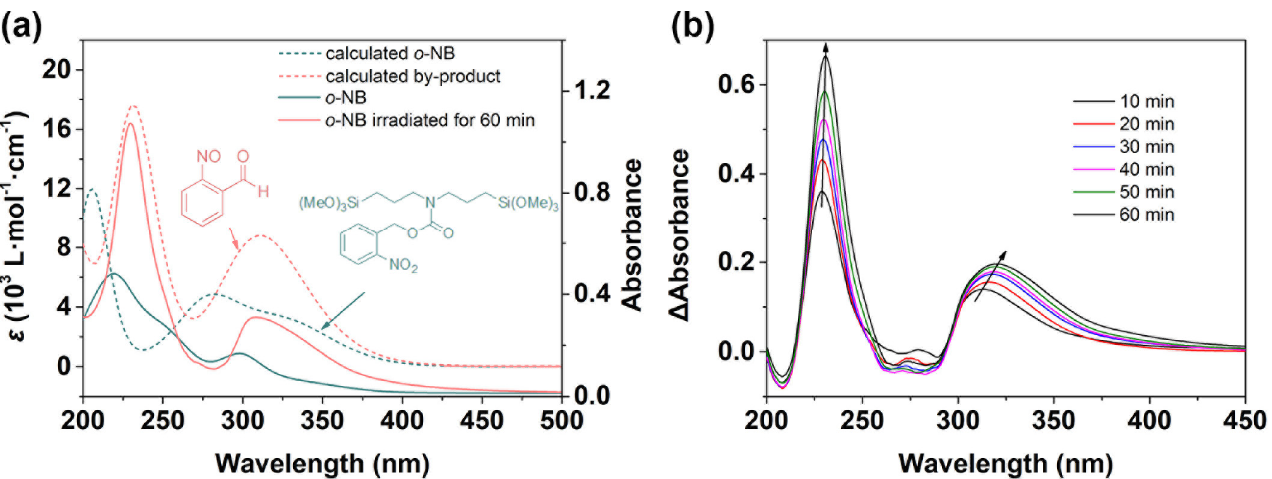
Figure 2. ( a ) The measured (solid line) and theory calculated (dotted line) UV–vis spectra of o –NB in THF solution under light irradiation at 254 nm. ( b ) UV–vis absorption spectra of light irradiated o –NB for different times.